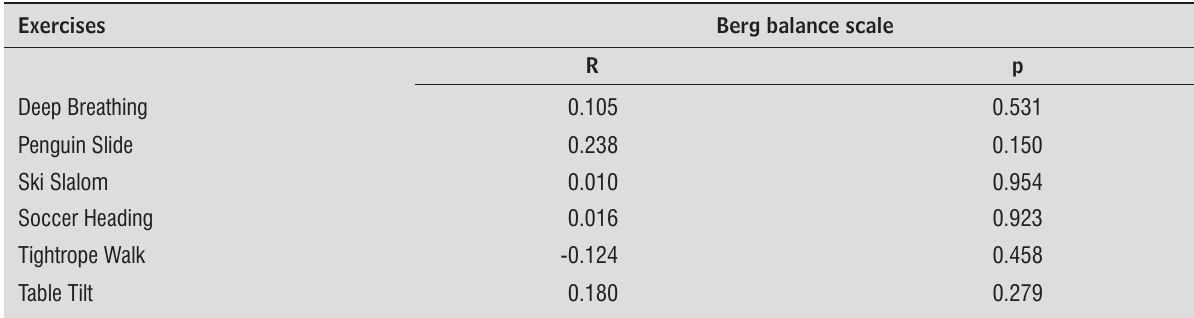
Table 4 - Correlation between the mean values of the six exercises in the 20 th session and BBS